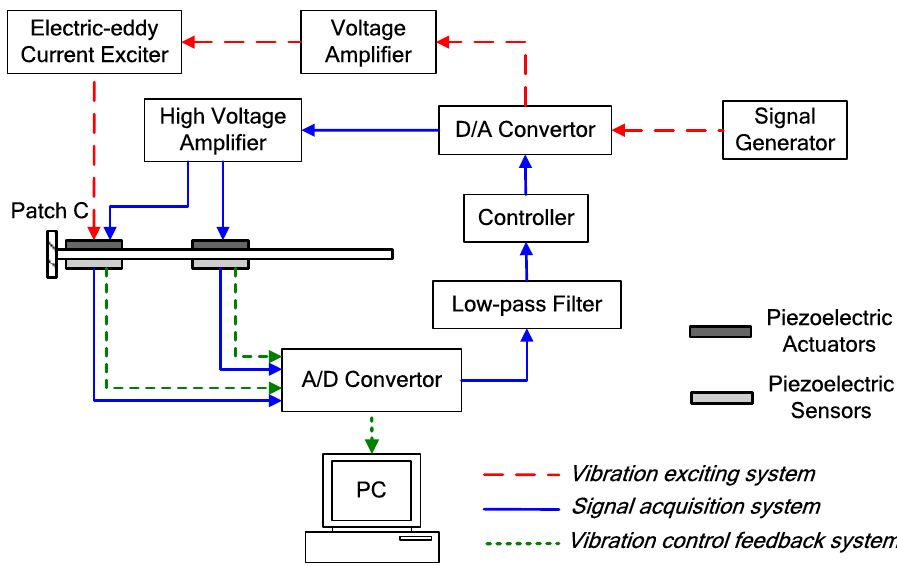
Figure 17. Block diagram of the experimental system.